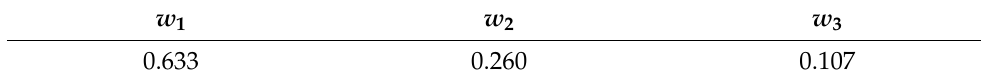
Table 1. Weights of the knowledge difficulty model.